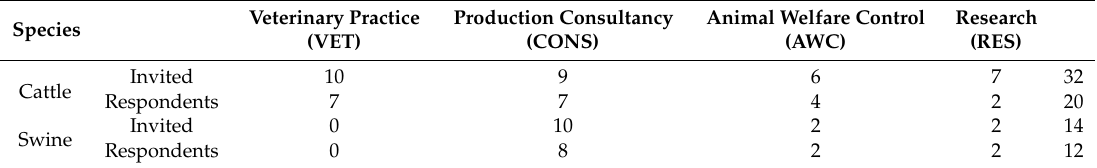
Table 1. A summary of respondents in two online surveys on animal welfare for Danish cattle (2011) and Danish swine experts